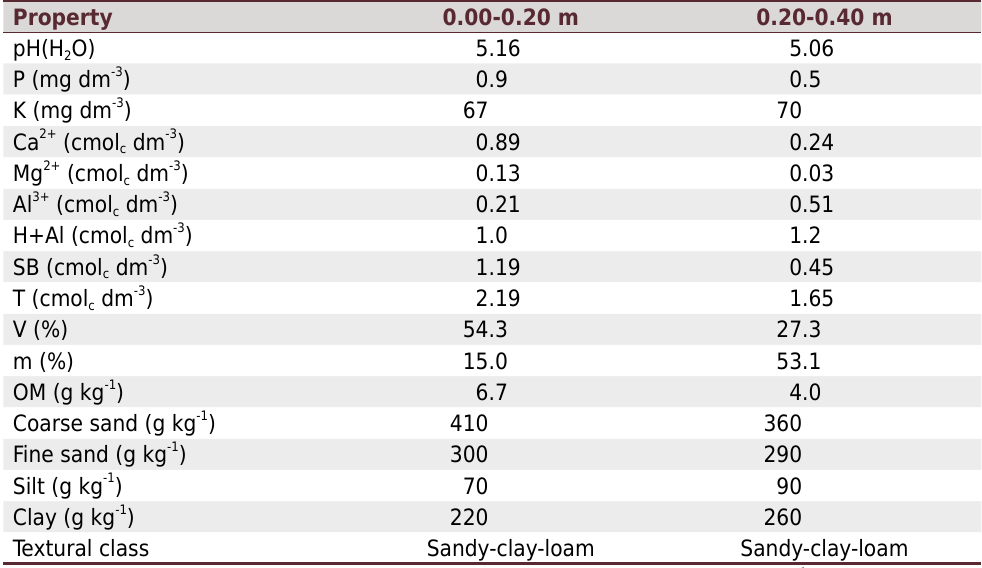
Table 1. Chemical and physical properties of the soil in the experimental area for the 0.00-0.20 and 0.20-0.40 m depth layers prior to setting up the experiment